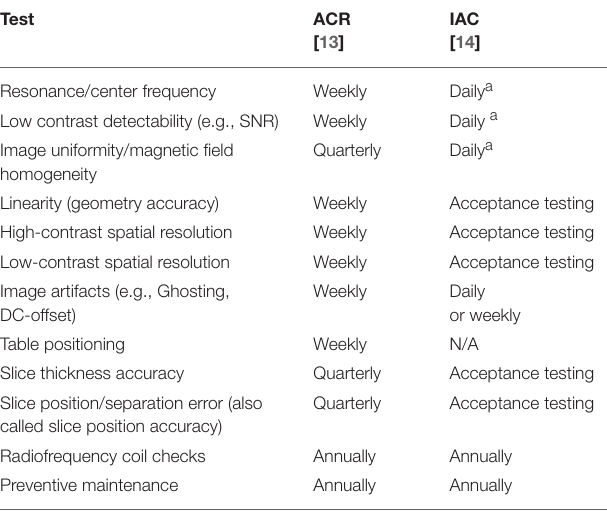
TABLE 2 | QC tests and testing frequencies for MRI systems.